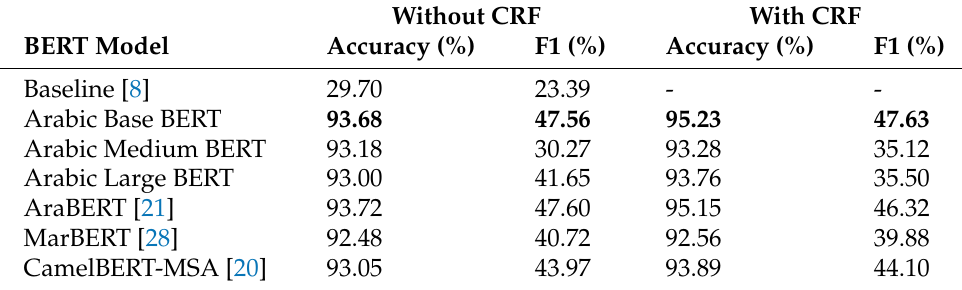
Table 3. Performance results with different